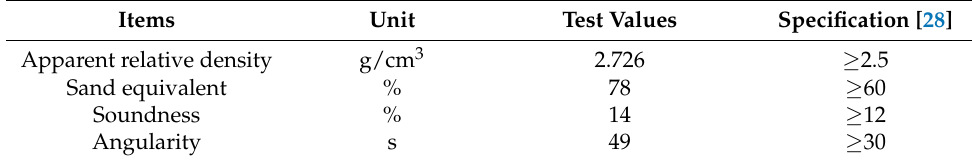
Table 4. Properties of fine